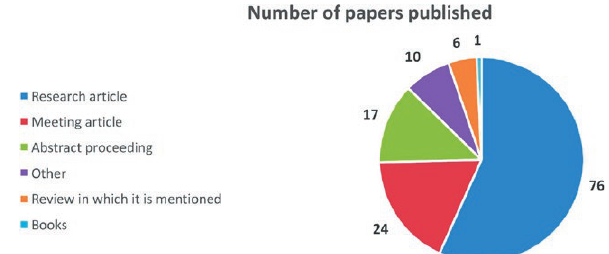
Figure 1. Number of published papers dealing with Fomitipo- ria mediterranea from 2002 ( Fmed identification date) to 2021, as indexed in the Web of Science TM database (Thomson